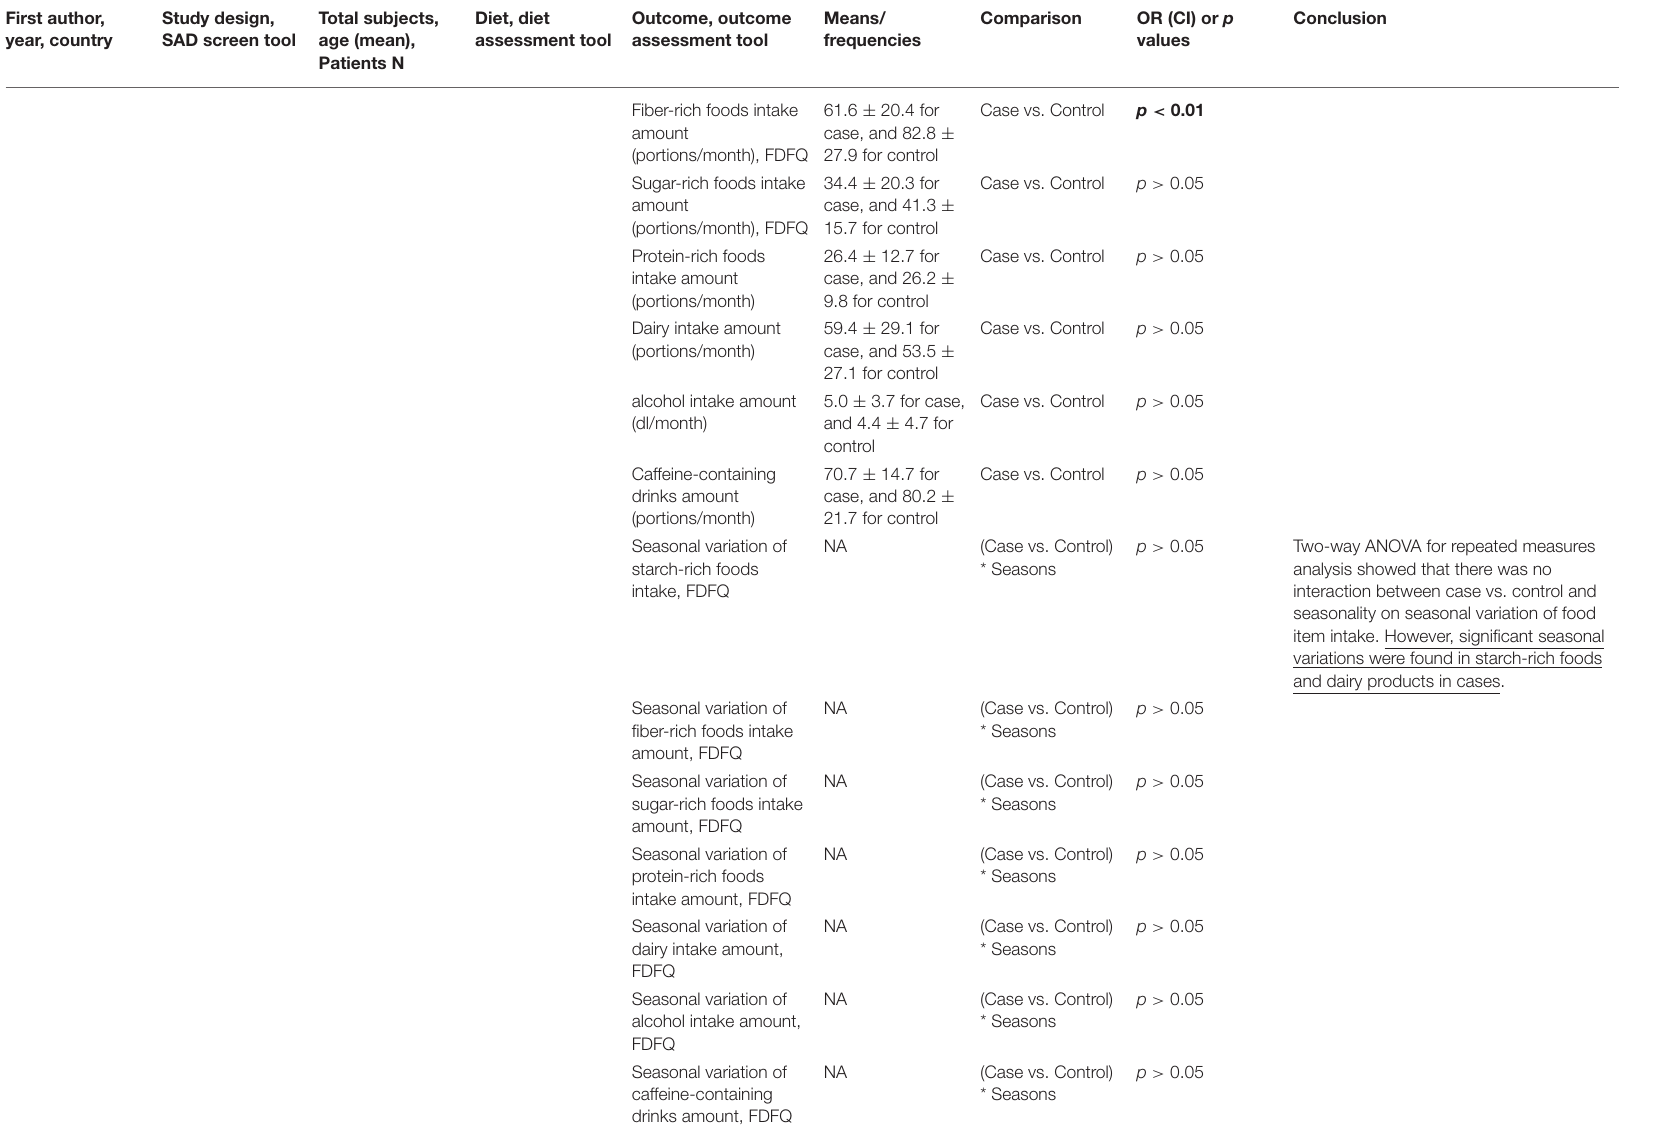
FFQ, Food Frequency Questionnaire; SPAQ, Seasonal Pattern Assessment Questionnaire; GSS, Global Seasonality Score; DSM, Diagnostic and Statistical manual of Mental disorders; M-CIDI, The World Health Organization Composite International Diagnostic Interview, the Munich version; ADD, Alcohol dependence disorder in lifetime; AUD, Alcohol use disorder in lifetime; SIGH-SAD, Structured Interview Guide for the Hamilton Depression Rating Scale, Seasonal Affective Disorders; SCID, DSM-IV Structured Clinical Interview for Depression; NR, Not report; Underlined context, detailed data not shown in the publication; Bold text, Statistically significant. a Calculated according to the information